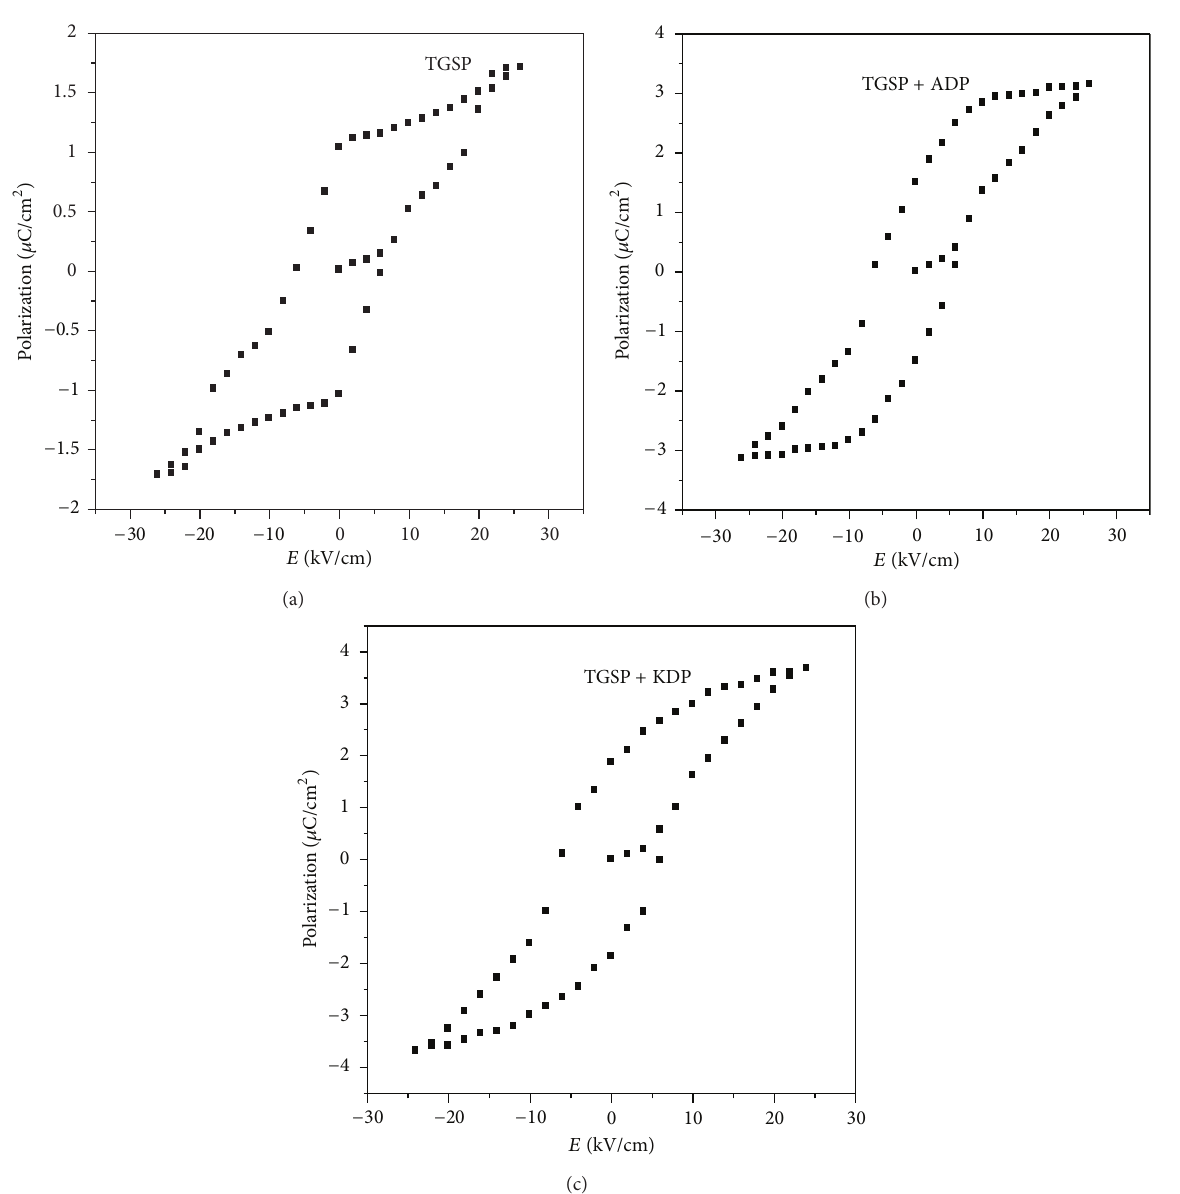
Figure 7: Ferroelectric hysteresis loops of (a) TGSP, (b) TGSP + ADP, and (c) TGSP + KDP